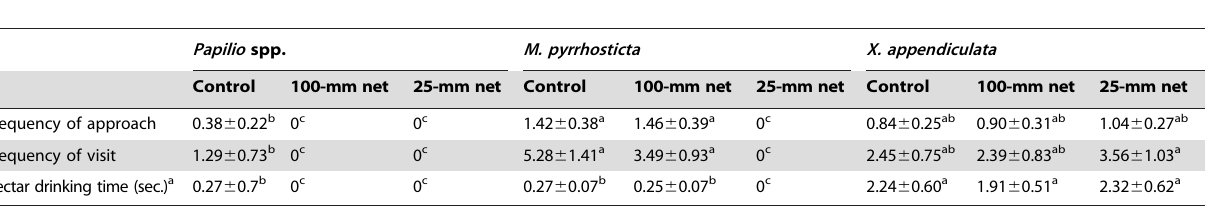
Table 3. Frequencies and duration of insect group behaviors under natural conditions and under the flower visitor barriers per hour in 2010.